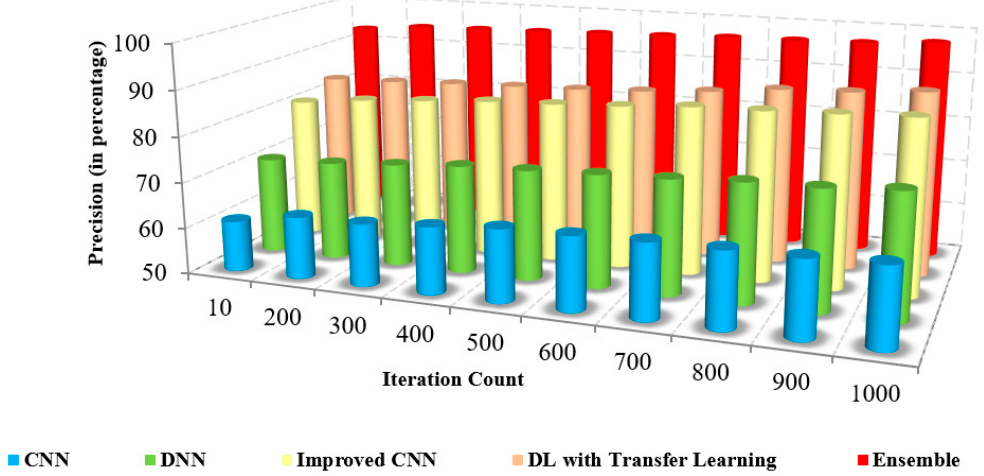
Figure 8. Iteration count vs. precision.